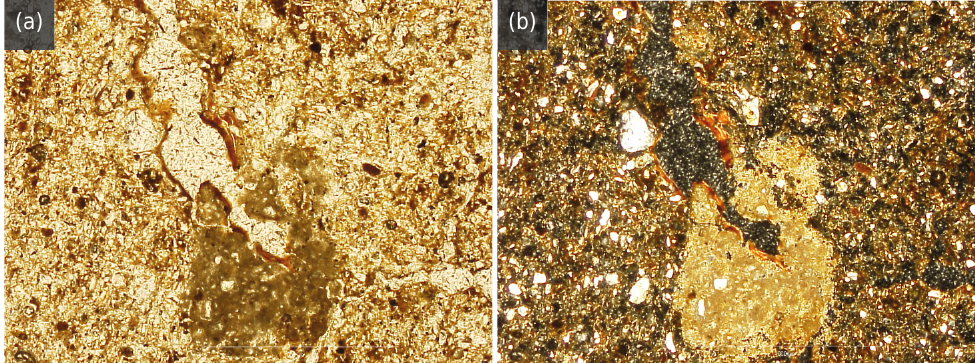
Figure 6. Photomicrography of the 2Btnk horizon of P2 and clay coatings (arrow) in the middle of a calcium carbonate (Ca) nodule fractured in flat light (PPL) (a); and with crossed nicols (XPL) (b), indicating that the clay coating is more recent and, hierarchically, is the most